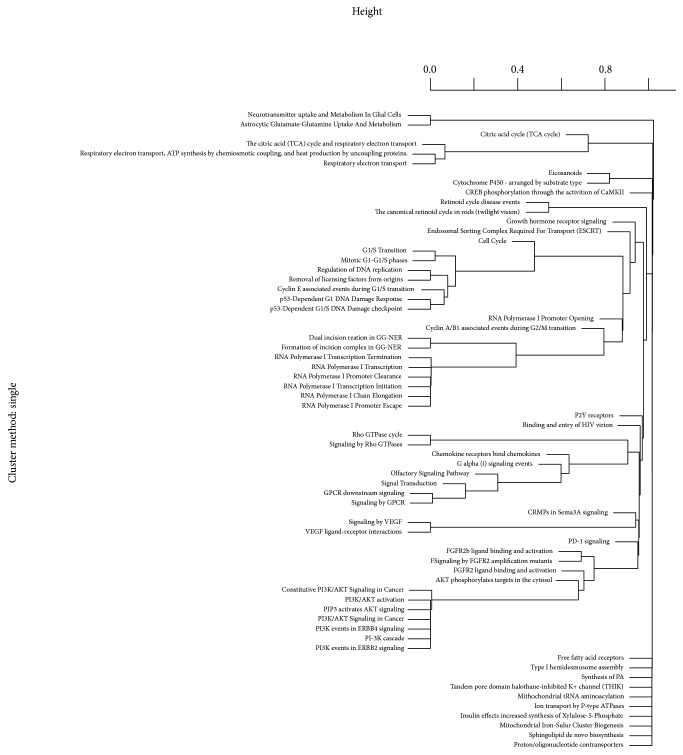
Gene content clustering of significant pathways in ALIGATOR analysis under three thresholds for nominal significance.